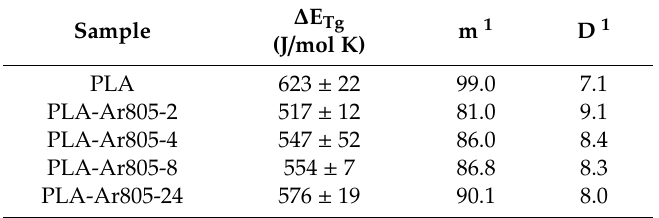
Table 5. Activation energy at T g ( ∆ E Tg ) and fragility parameters of PLA and relative nanocomposites.